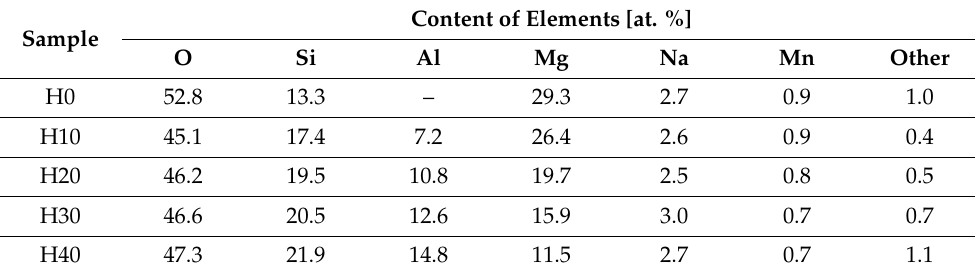
Table 2. The elemental composition of the studied